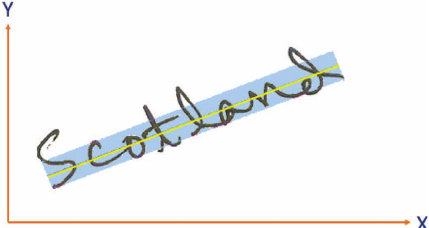
Figure 5: Best-Fitting Line ( L ) and Approximate Core Region ( P ′ ) Marked by Shaded Region.